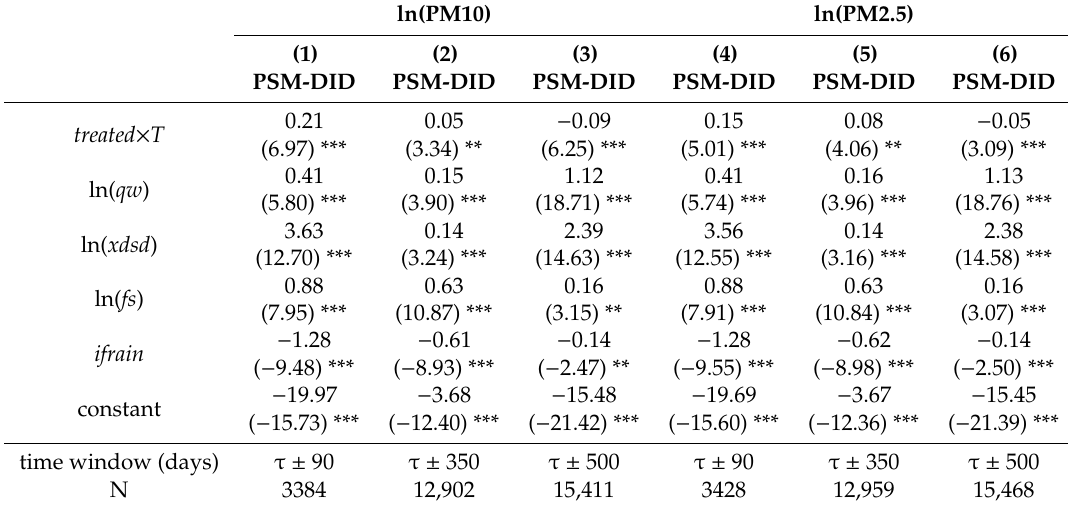
Table 6. PSM-DID estimates with varying time